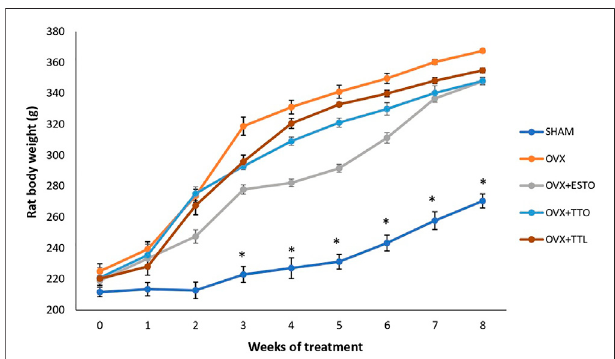
FIGURE 2 | Body weights. SHAM, sham-operated group; OVX, ovariectomized control group; OVX + ESTO, ovariectomized + oral estrogen; OVX + TTO, ovariectomized + daily oral tocotrienol; OVX + TTL, ovariectomized + IO injection of tocotrienol + PLGA. *Signi fi cant difference ( p < 0.05) when compared with the SHAM. The data were expressed as mean ±